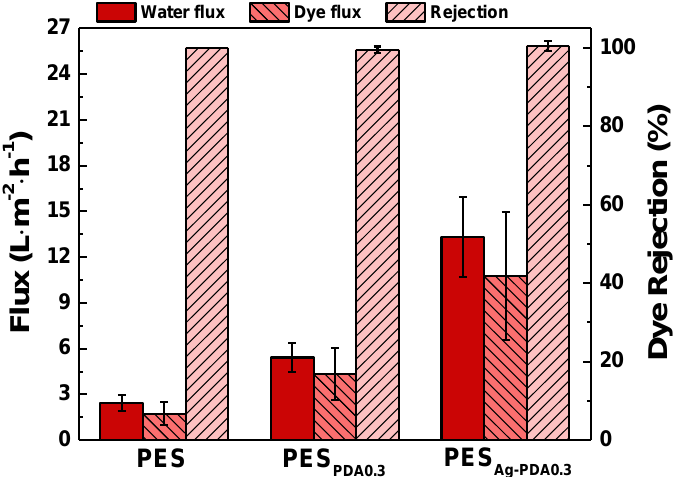
Figure 7. Performance comparison of PES, PES PDA0.3 , and PES Ag-PDA0.3 . Feed = 50 ppm Rose Bengal; Operating pressure 4 bar; Operating temperature = 30 °C.